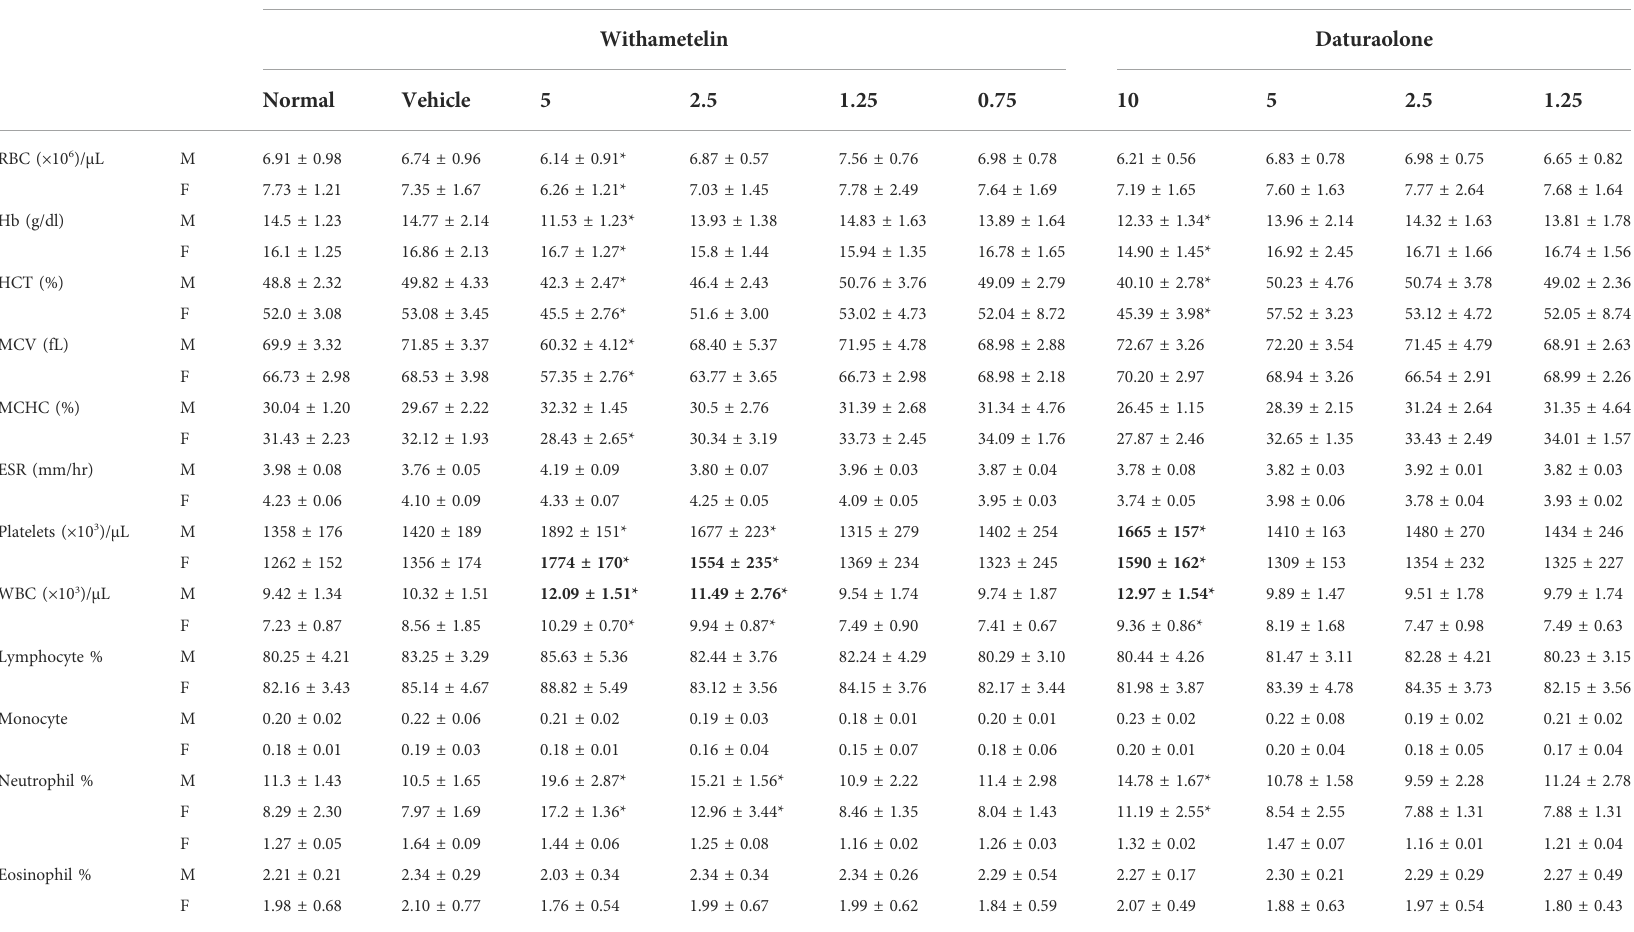
TABLE 3 Hematology results after 28 days respectively.